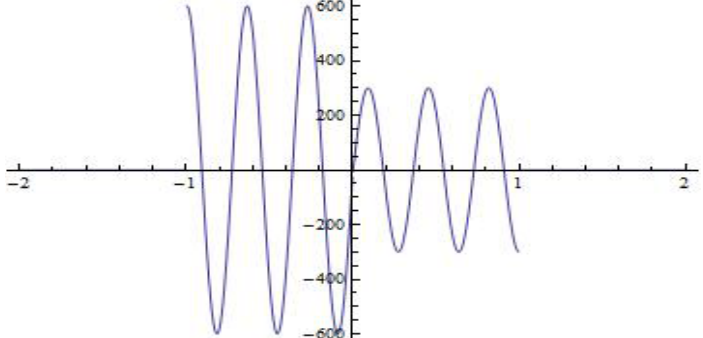
Figure 6. Graph of the second fundamental solution y = χ ( x , λ ) for λ = 30. (This graph was sketched by using “Mathematica 8”).